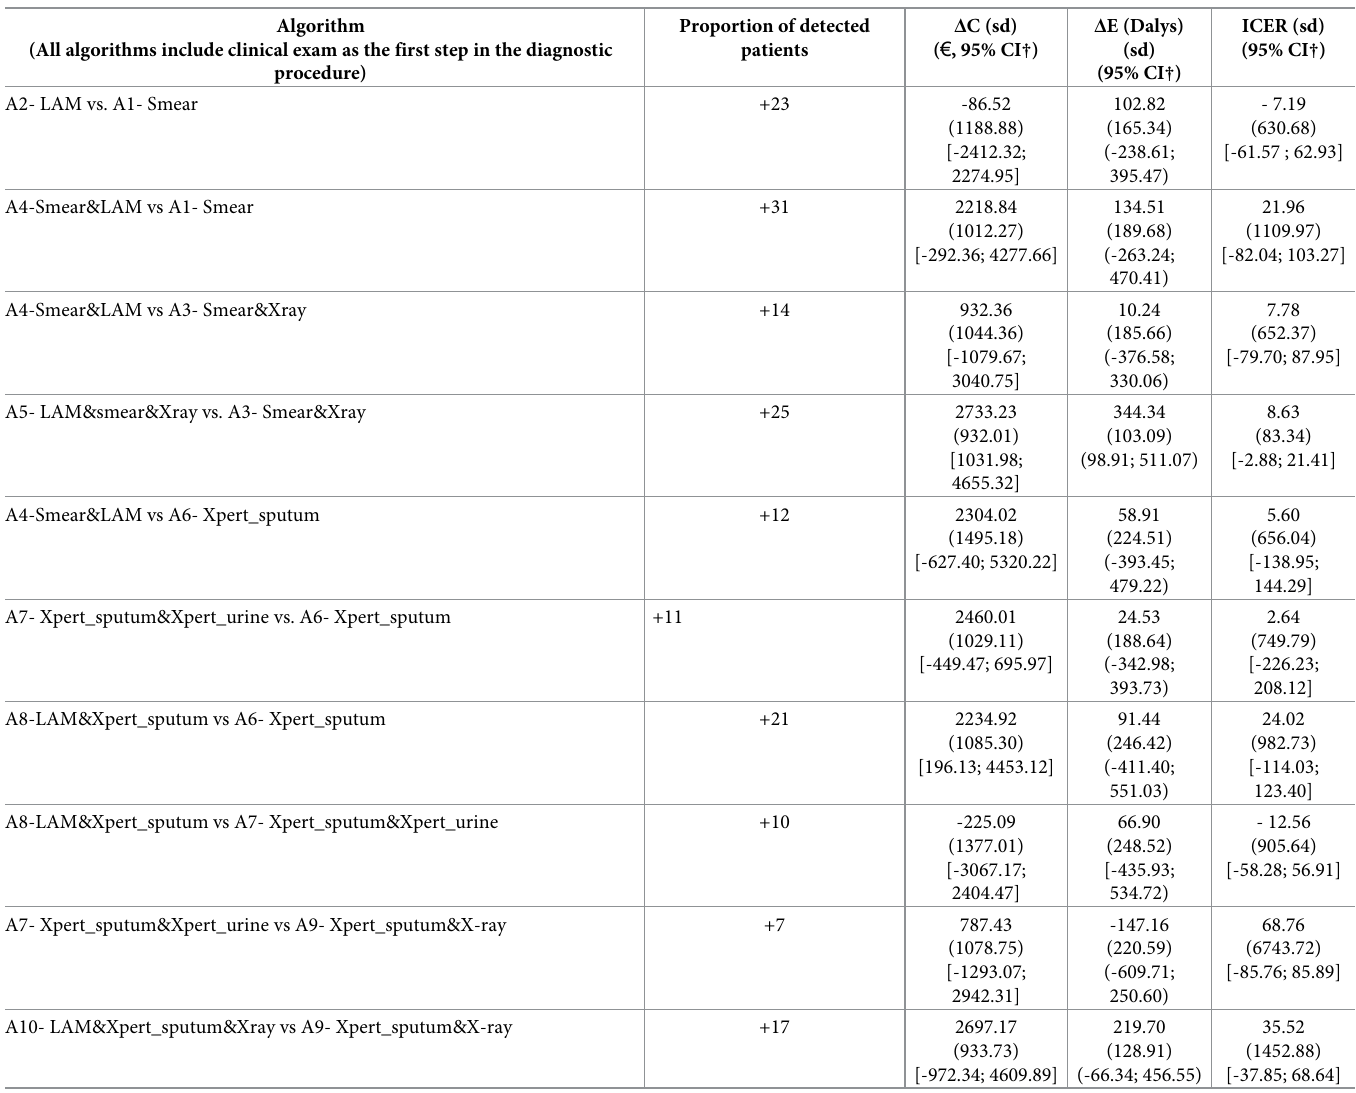
Table 4. Incremental cost, incremental DALYs averted and ICER. Algorithm (All algorithms include clinical exam as the first step in the